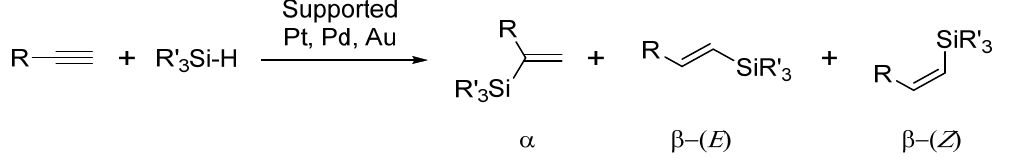
Figure 1. Transition metal catalyzed hydrosilylation of terminal acetylenes leading to isomeric vinlysilanes.